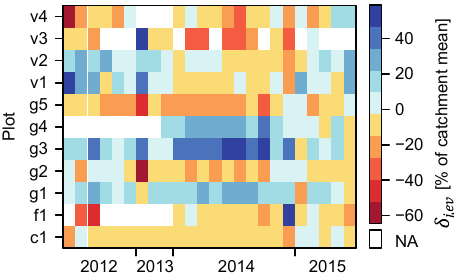
Figure 3. Temporal stability (Vachaud et al., 1985): the relative dif- ference between the plot mean and the catchment mean δ j, ev for each on-alert measurement and each plot where on-alert measure- ments were conducted (four vineyards v1–v4, five grasslands g1– g5, one fallow f1 and one cultivated field c1). Note that the time axis represents a sequence of events, no equidistant time line. Blue squares show plots with plot means that exceed the catchment mean, red squares are those with plot means below the catchment mean, and white squares indicate plots that were not sampled during the respective